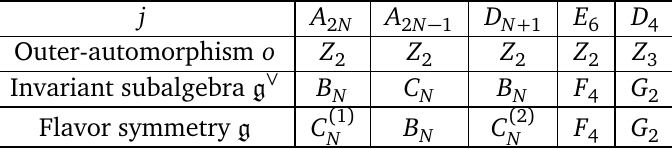
Table 2: Outer-automorphisms of simple Lie algebras j , its invariant subalgebra g ∨ and flavor symmetry g from the Langlands dual of g ∨ .